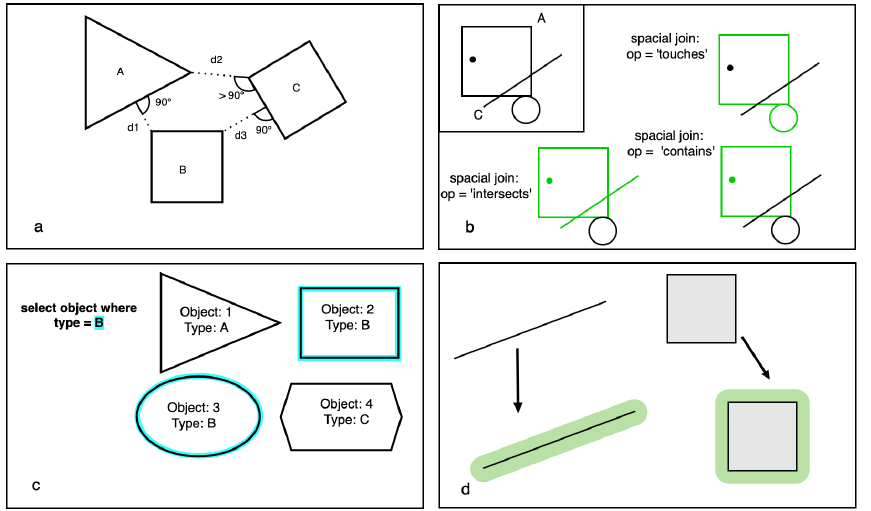
Figure 2. Overview of some of the geospatial analyses used in GeoPandas, with distance shown in ( a ), spatial join in ( b ), query by attribute in ( c ), and buffer in ( d